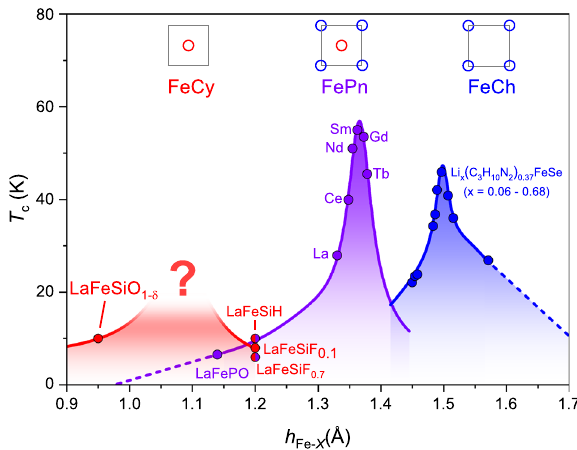
Fig. 6 Anion-height dependence of T c . Superconducting transition temperature T c as a function of the anion height from the Fe plane h Fe-X for pnictides (Pn) in purple (labeled with RE for REFeA- sO 1 − x (H,F) x ) 1 (and references therein), heavily electron-doped chalcogenides (Ch) in blue 53 and crystallogenides (Cy) in red (LaFeSiO 1 − δ (this work), LaFeSiF x 5 , and LaFeSiH 4 ). The sketches illustrate the simpli fi ed Fermi surfaces of these materials and LaFeSiH and LaFeSiF 0.7 are marked in red/purple to indicate that the Fermiology of these crystallogneides bear resemblance to the pnictides. The T c of the pnictides and chalcogenides peaks at different h Fe-X values, which can be ascribed to their different Fermiology (and hence paring mechanism). The superconducting crystallogenide LaFeSiO 1 − δ reported in this work provides yet another Fermiology and appears above the tail of the pnictide T c ( h Fe-X )